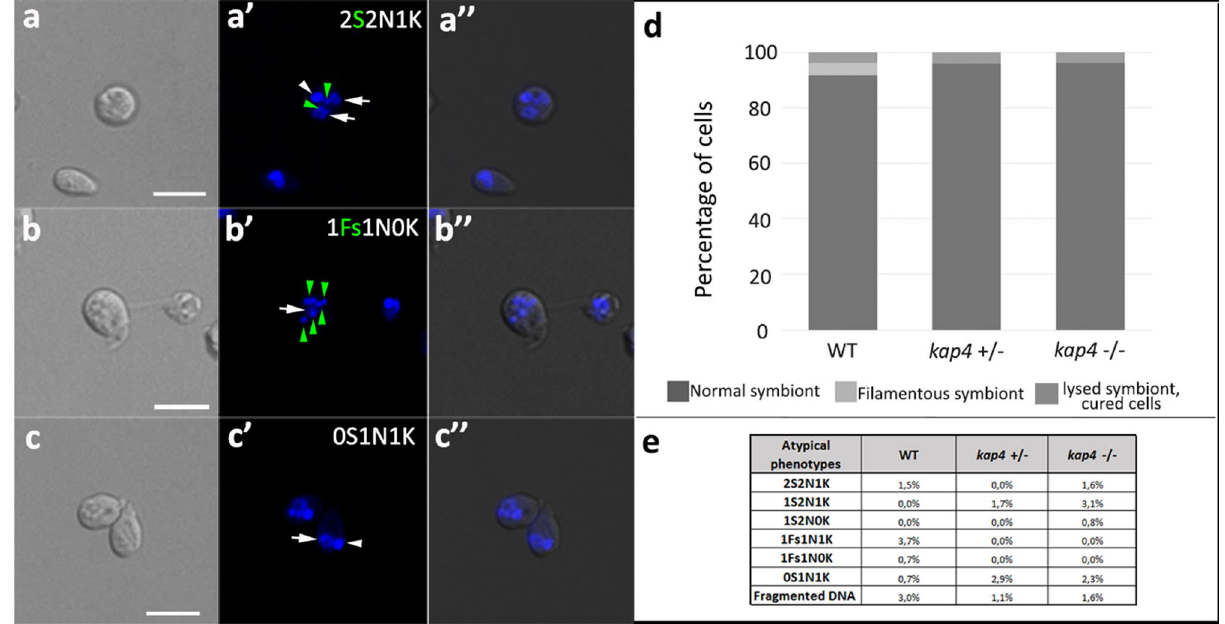
Figure 8. DAPI-stained protozoa exposed to UV irradiation presented atypical phenotypes. Such morphotypes were observed in WT cells ( a – a ″ ), as well as in kap4 +⁄− ( b – b ″ ) and kap4 −⁄− ( c – c ″ ) mutant cells. ( a – a ″ ) Protozoa harboring two symbionts, two nuclei, and one kinetoplast. ( b – b ″ ) A dyskinetoplastic protozoan, with a filamentous symbiont containing multiple nucleoids and one nucleus. ( c – c ″ ) A cured cell containing one nucleus and one kinetoplast. ( d ) Counting of cellular patterns considering the presence of normal or filamentous symbionts, as well as cured cells (that lost the symbiont) or lysed symbionts. ( e ) Percentage of cells presenting atypical phenotypes. S Symbiont and Fs Filamentous symbiont, green arrowheads indicate bacterium nucleoids; N nucleus—white arrows; K kinetoplast—white arrowhead. Bars 5 μm. A total of 1000 WT and KAP4 mutant cells were counted in 3 independent